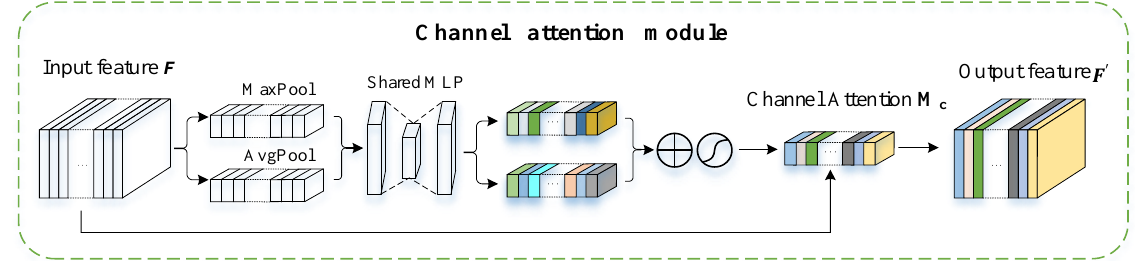
Figure 3. Schematic diagram of the channel attention module.